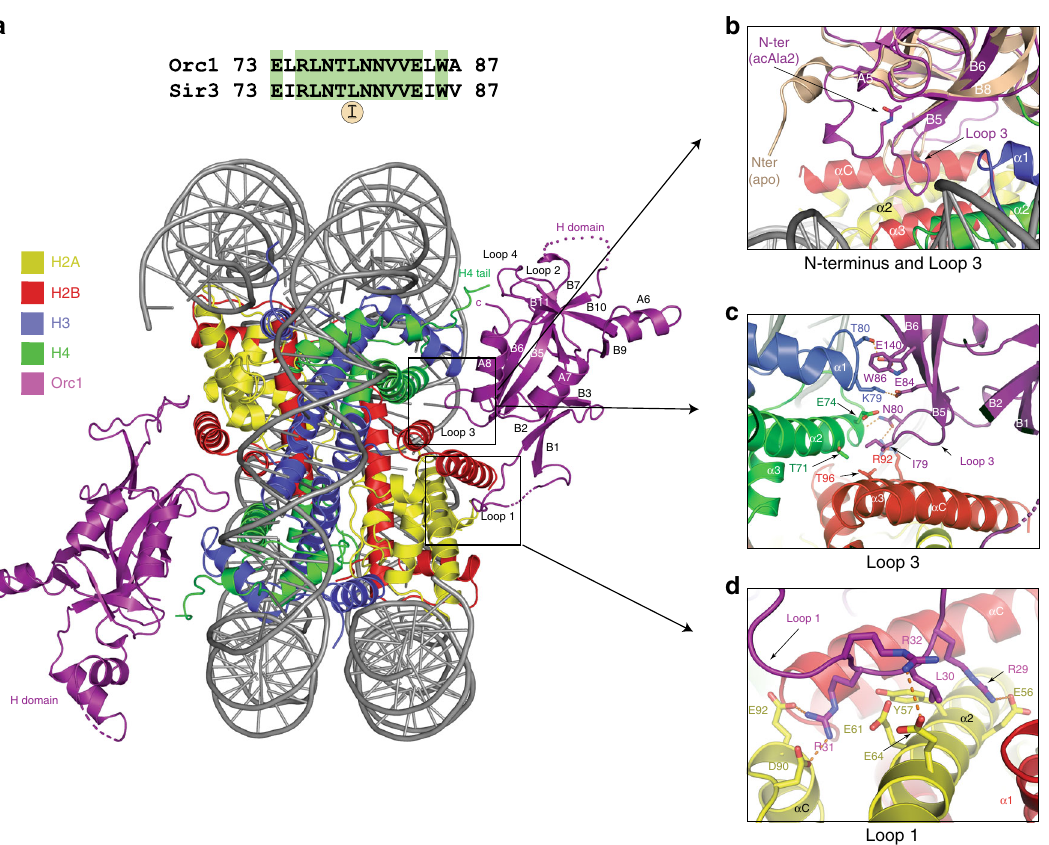
Fig. 1 Overview of the structure and main interfaces. a Sequence alignment of Loop 3 in Orc1 and Sir3 with conserved leucine 79 (Top). Front view of the Orc1 BAH-Nucleosome complex (Bottom). The structure is color coded (BAH in purple, H2A in yellow, H2B in red, H3 in blue, H4 in green, and DNA in gray). b – d Main interfaces between Orc1 BAH and nucleosome are indicated in squares. b Conformation of acetylated N-terminus of Orc1. Superposition of the unacetylated, apo Orc1 structure (from PDB ID: 1M4Z; light brown) shows structural rearrangements of the N-terminus of the BAH domain. c Orc1 interactions with LRS region on nucleosome. d Details of Loop 1 interactions with acidic patch on the nucleosome. Important residues are highlighted and depicted in sticks. Hydrogen bonds are shown as dashed